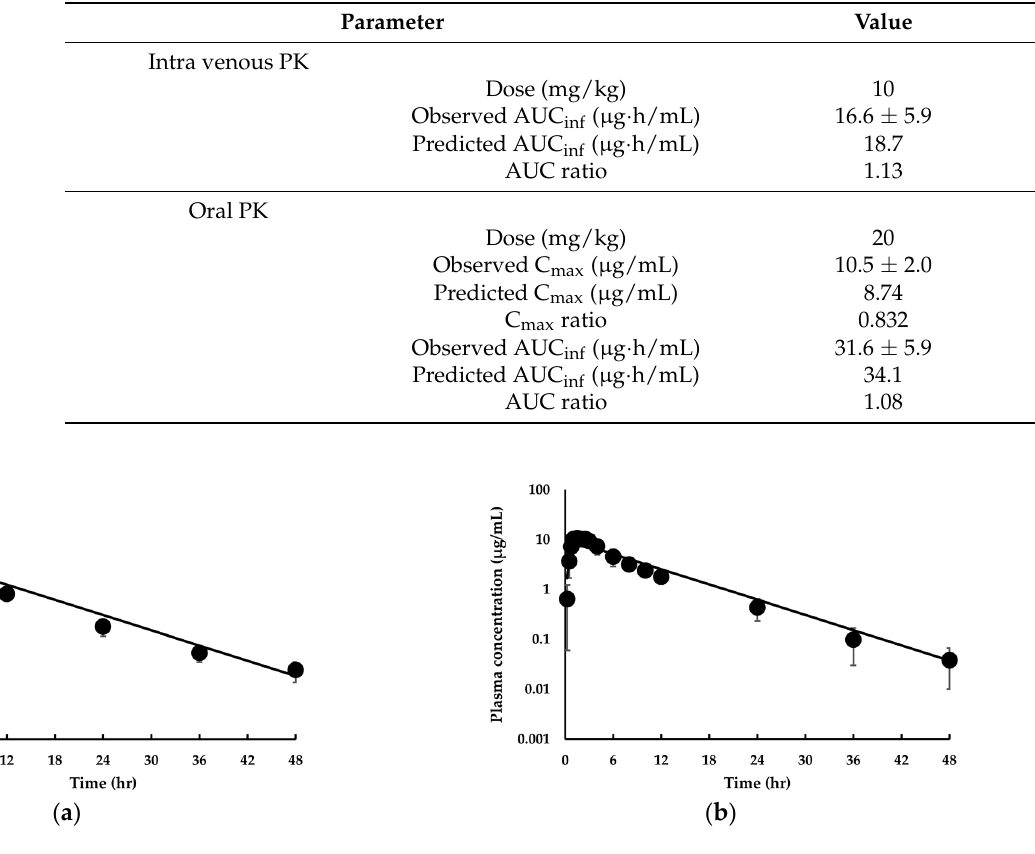
Figure 6. Human PBPK model prediction of plasma IDP-73152 concentrations following ( a ) 640 and ( b ) 1280 mg oral administration in humans. Solid lines represent predicted data. Closed circles (•) represent observed data. Observed data are means ± SD ( n = 8 humans). Table 6. Observed 1 and predicted PK parameters of IDP-73152 in humans.